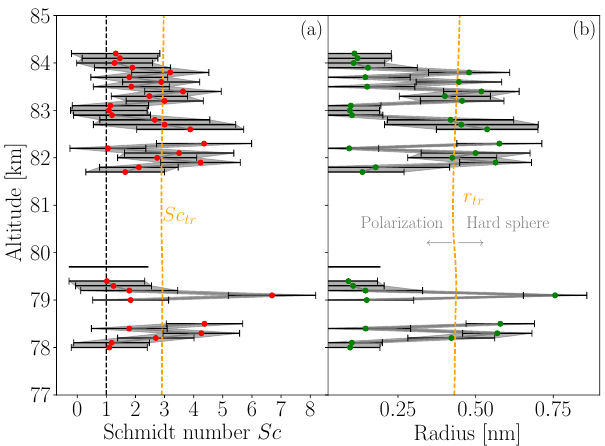
Figure 12. (a) Schmidt number as a function of altitude obtained from fitting the Driscoll and Kennedy theoretical model (red dots). For orientation Sc = 1 is marked by the black dashed line and the transition of polarization and hard sphere interaction by orange dashed line Sc tr . The black bars and grey shaded areas indicate the error of the Schmidt numbers (see text for details). (b) Mean √ Sc ) obtained from Schmidt numbers charged particle radius ( r ∼ (green dots). The orange dashed line indicate again the transition be- tween polarization and hard sphere interaction. Error bars are given in black and grey shaded areas (see text for